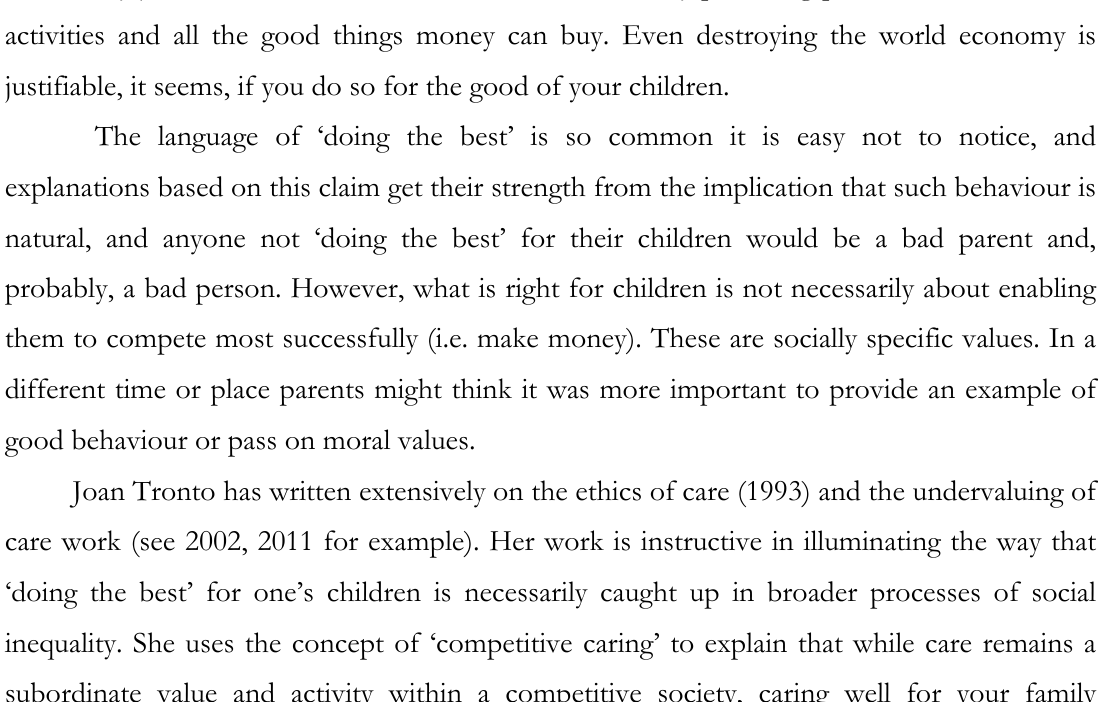
Rosie Cox: Competitive Mothering and Delegated Care: Class Relationships in Nanny and Au Pair